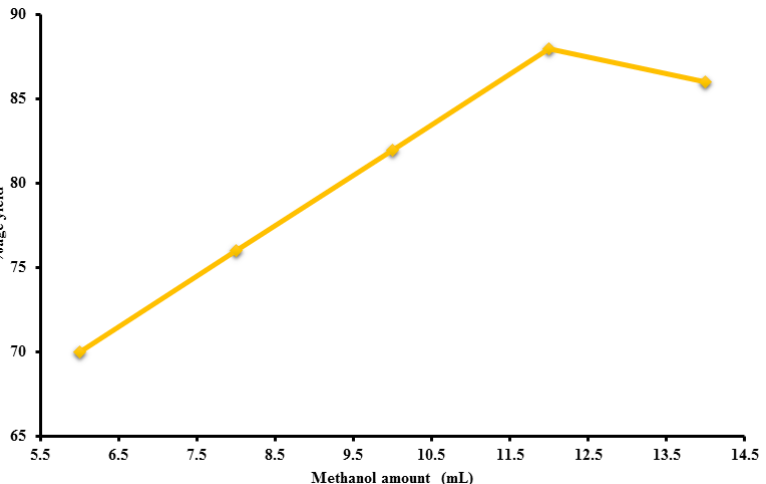
Figure 4. Graph showing the effect of methanol concentration changes on the percentahe yield of biodiesel.